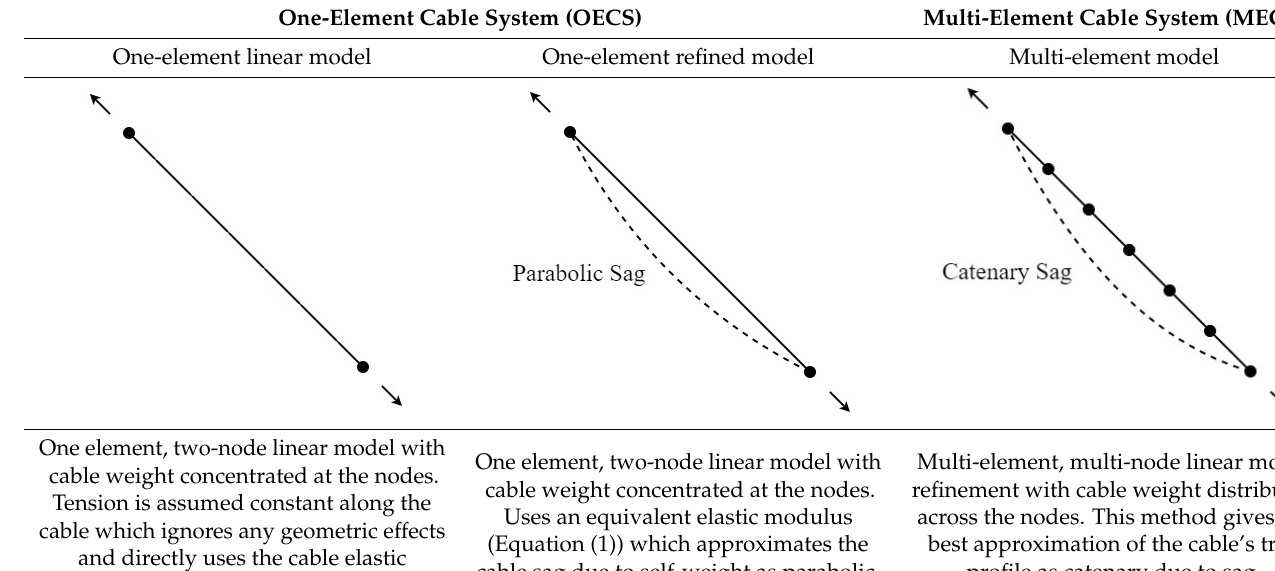
Table 1. Stay cable modelling approaches.